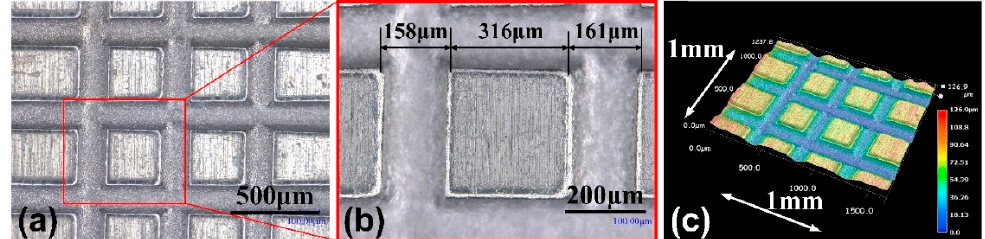
Figure 13. ( a , b ) Photographs and ( c ) 3D morphology of the array micro-grooves by two directions micro-electrochemical milling using indexing device.